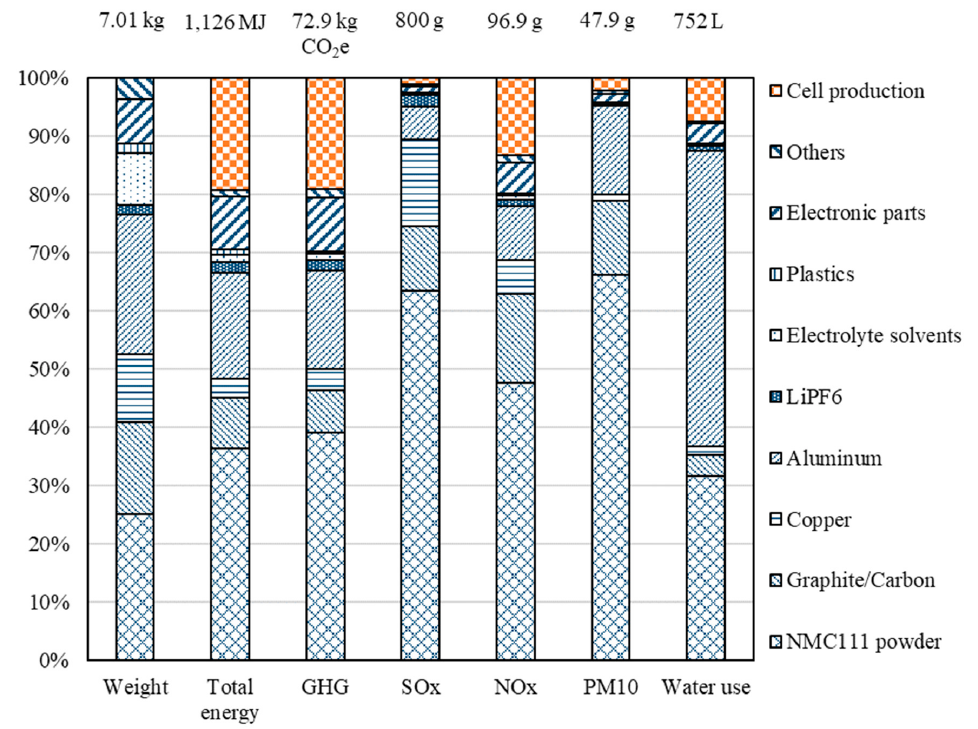
Figure 2. Cradle-to-gate impact breakdowns and bill of materials (BOM) of 1 kWh NMC111 battery. Blue denotes material inputs; orange denotes energy inputs for cell production.